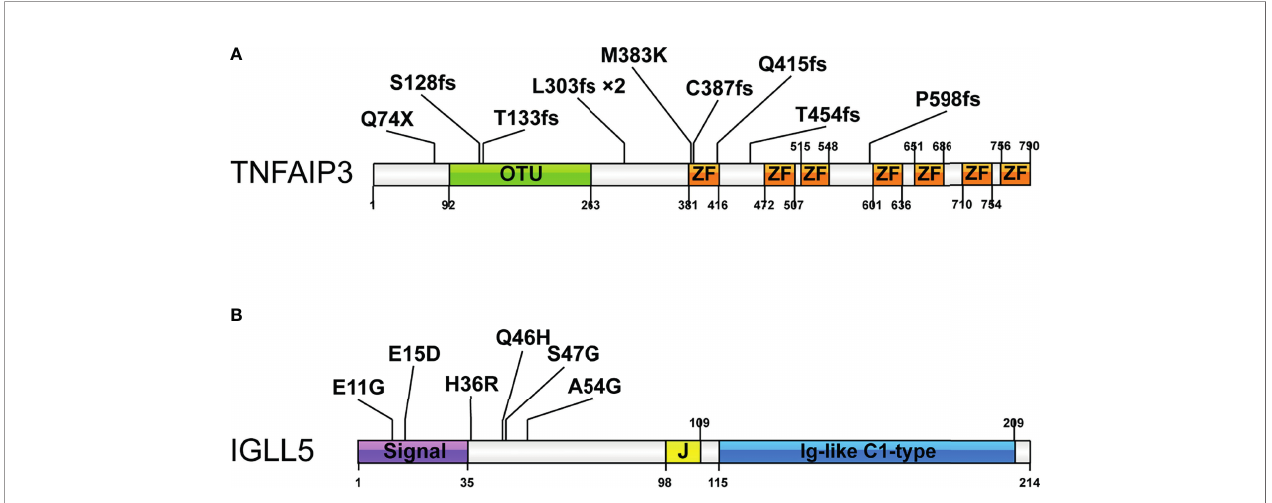
FIGURE 3 | Pattern and distribution of mutations in selected genes. (A) Tumor necrosis factor alpha-induced protein 3 ( TNFAIP3 ) and (B) Immunoglobulin lambda- like polypeptide 5 ( IGLL5 ). Colors describe the types of mutations: orange, missense mutation; blue, nonsense mutation; purple, frameshift insertion, or deletion. OTU-Ovarian tumor domain belong to the family of deubiquitinating cysteine proteases; ZF-zinc fi nger domain; Signal-signal regions; Ig-like C1-type immunoglobulin- like constant 1-type. *2 indicates the mutation occurred in 2